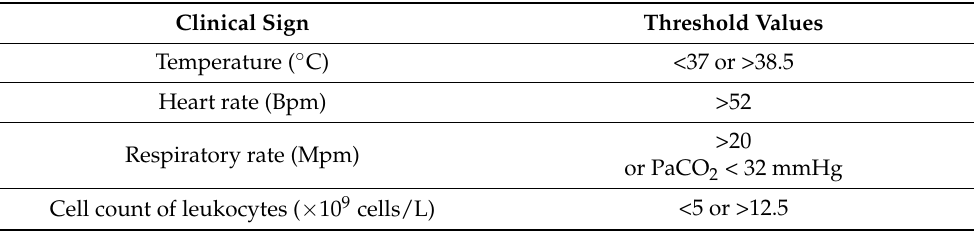
Table 4. Overview of threshold values defining SIRS according to Roy et al., 2017